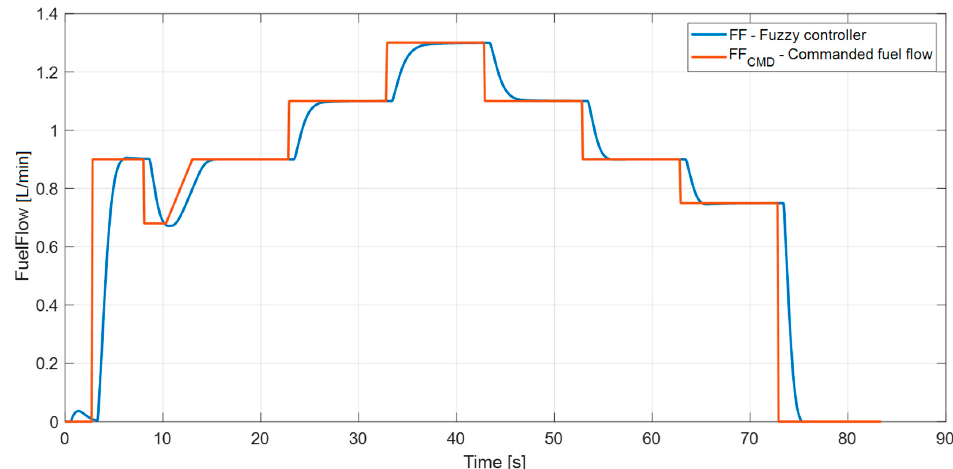
Figure 13. Fuzzy adaptive PID performance during a simulated fuel ‐ flow run.